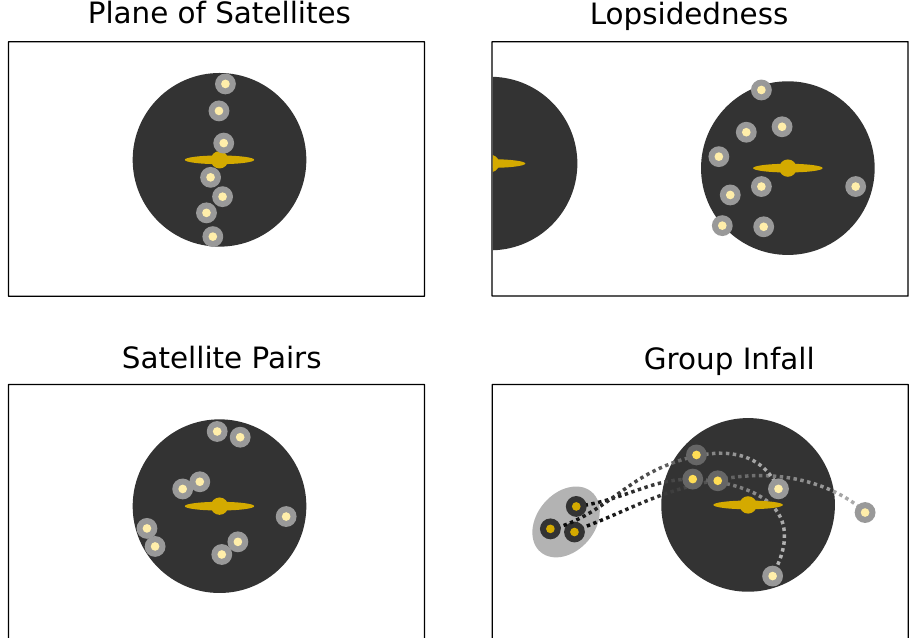
Figure 1. Schematic representations of different types of phase-space correlations that have been studied among systems of satellite galaxies. Clockwise starting from the top left: Planes of satellite galaxies (Section 2.2), lopsided satellite galaxy systems (Section 2.4), the infall of satellites in groups (Section 2.3), and close pairs of satellite galaxies (Section